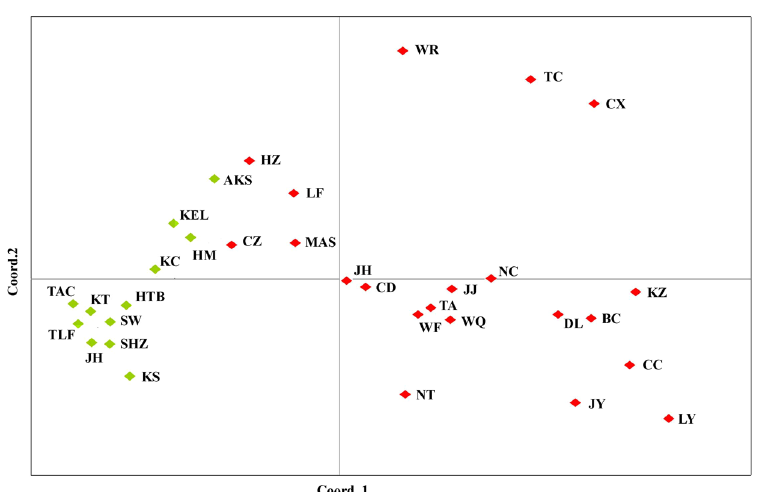
Figure 5. Principal coordinate analysis (PCoA) based on the genetic distance matrix of F ST values for microsatellite data. Population codes are given in Table 2. Colors within the diamond: red, eastern region group; green, western region